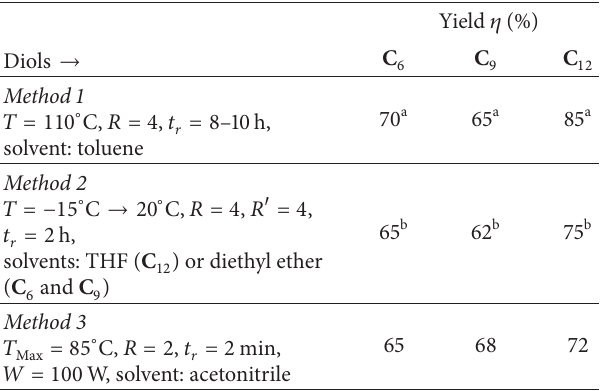
Table 1: Reaction conditions and results of the synthesized products with the different